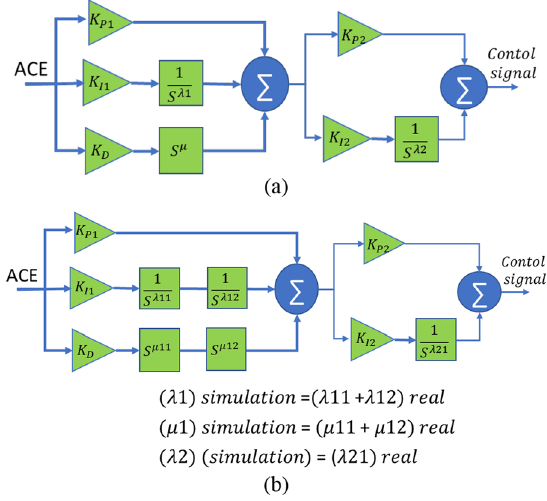
Fig. 4 a Proposed FOPID–FOPI controller structure reduced variables (simulation mode), b proposed FOPID–FOPI controller structure